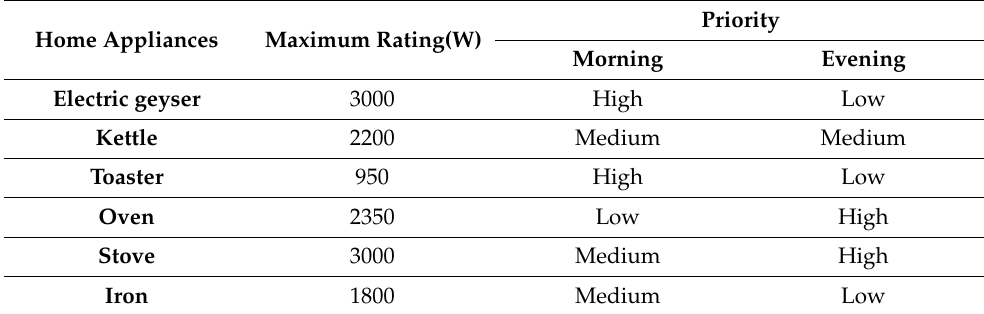
Figure 14. DRM with energy app .